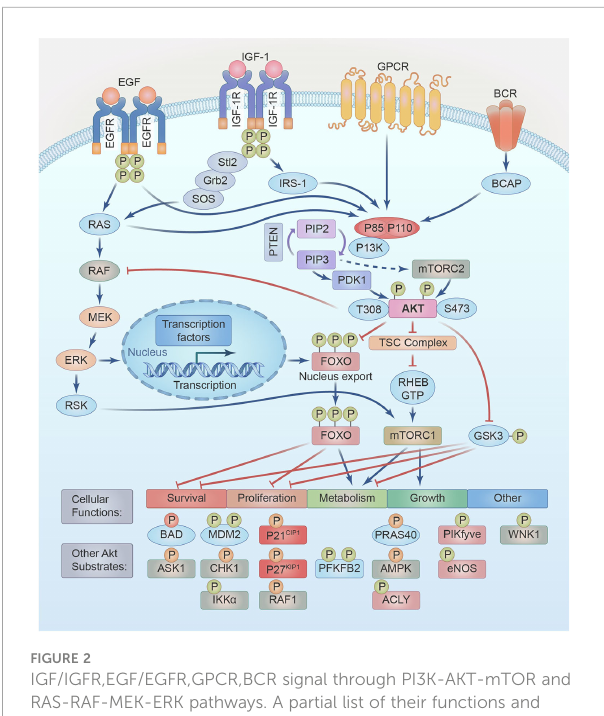
FIGURE 2 IGF/IGFR,EGF/EGFR,GPCR,BCR signal through PI3K-AKT-mTOR and RAS-RAF-MEK-ERK pathways. A partial list of their functions and substrates are